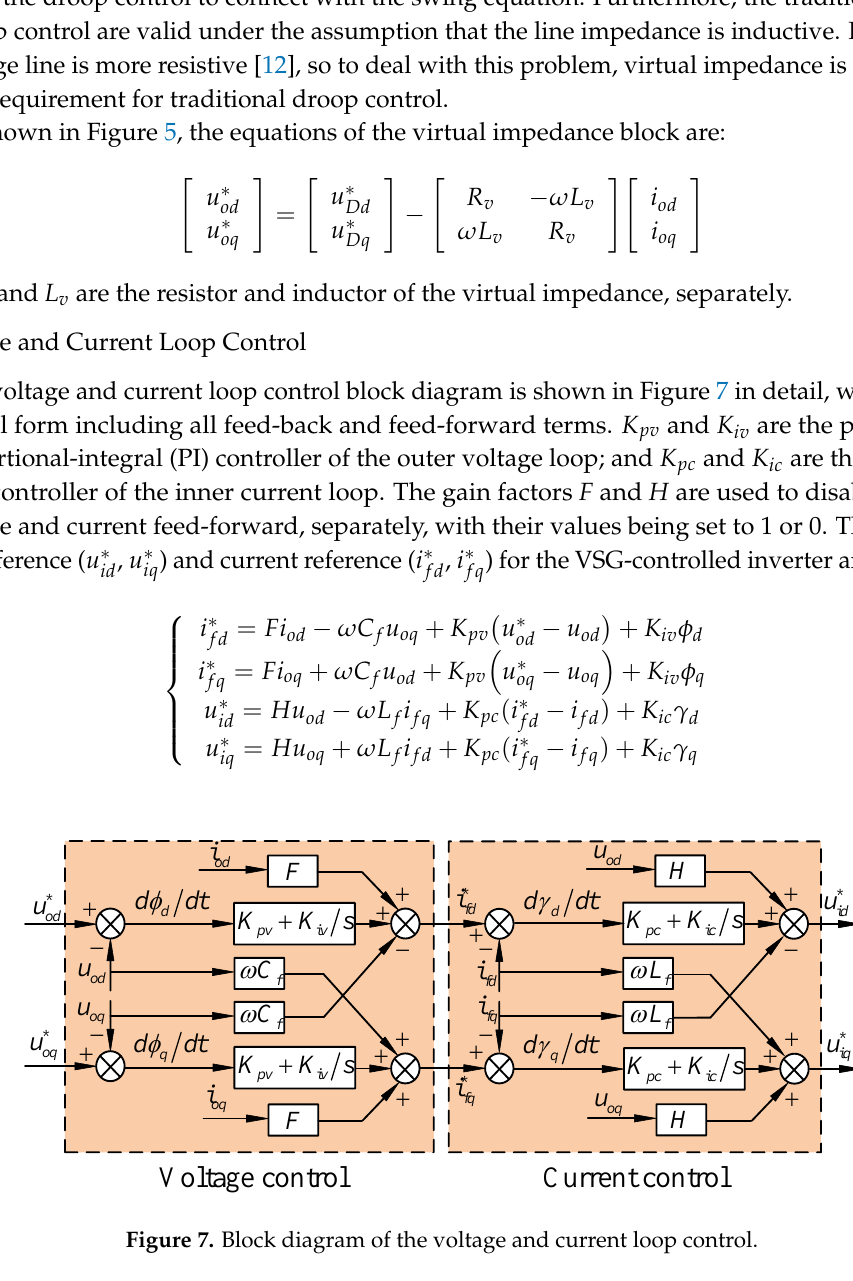
Figure 6. Power calculator.